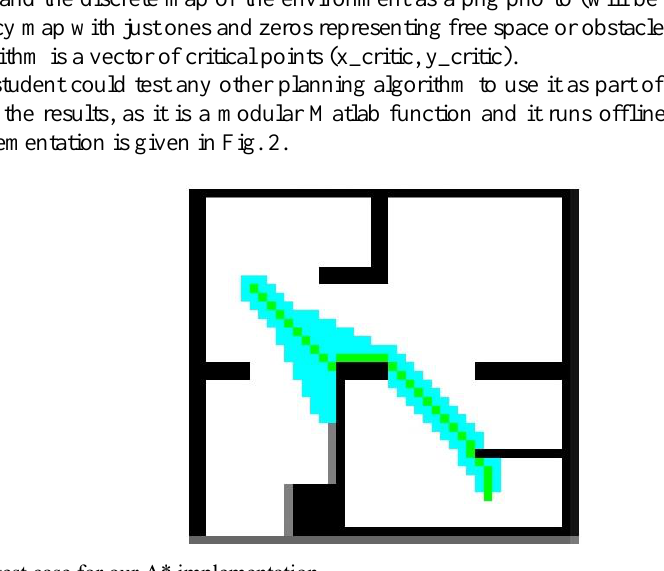
Fig. 2. A test case for our A*